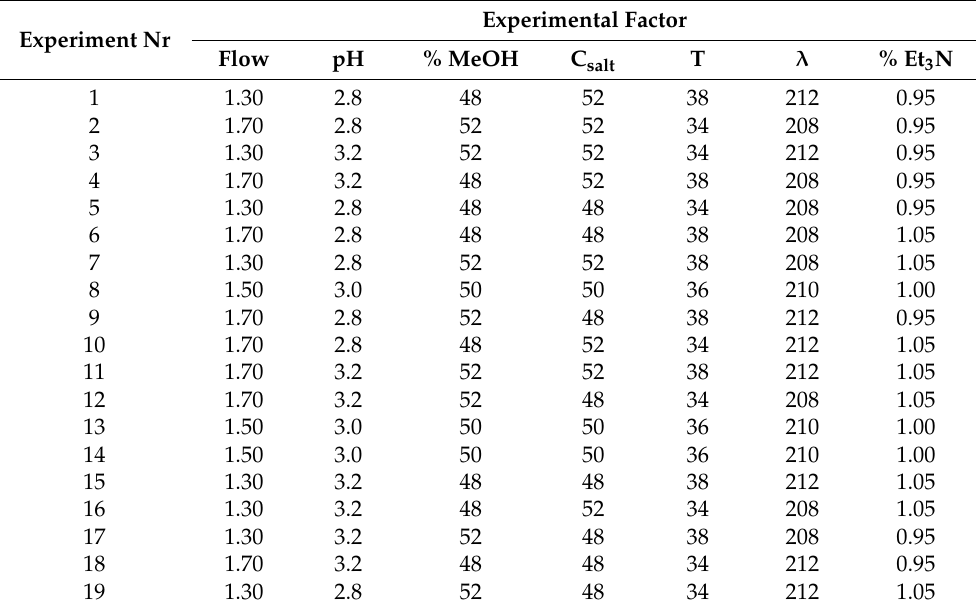
Table 2. The total of 19 experiments proposed by the software for